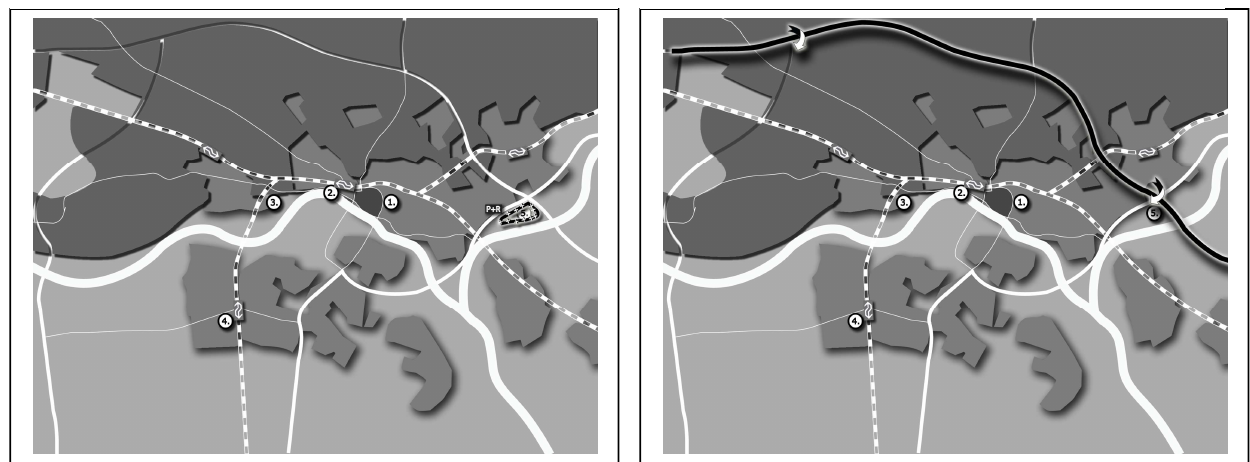
Figure 2. ITS scenarios visualized for the city of Arnhem Numbers in maps: five most important office locations in